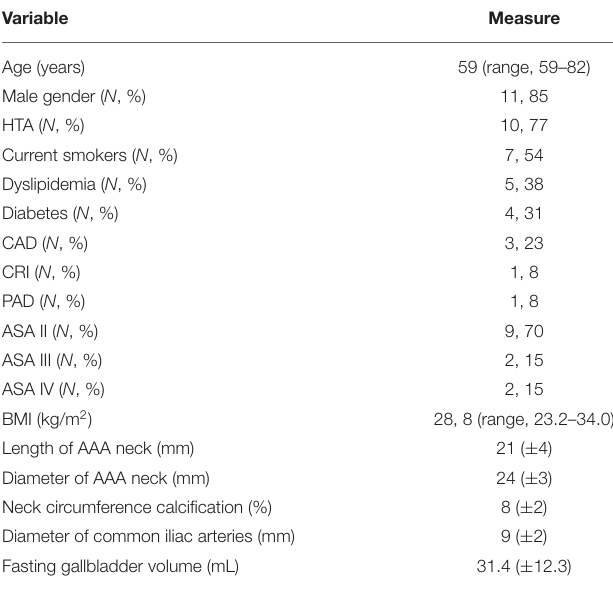
TABLE 1 | Demographics, risk factors and baseline